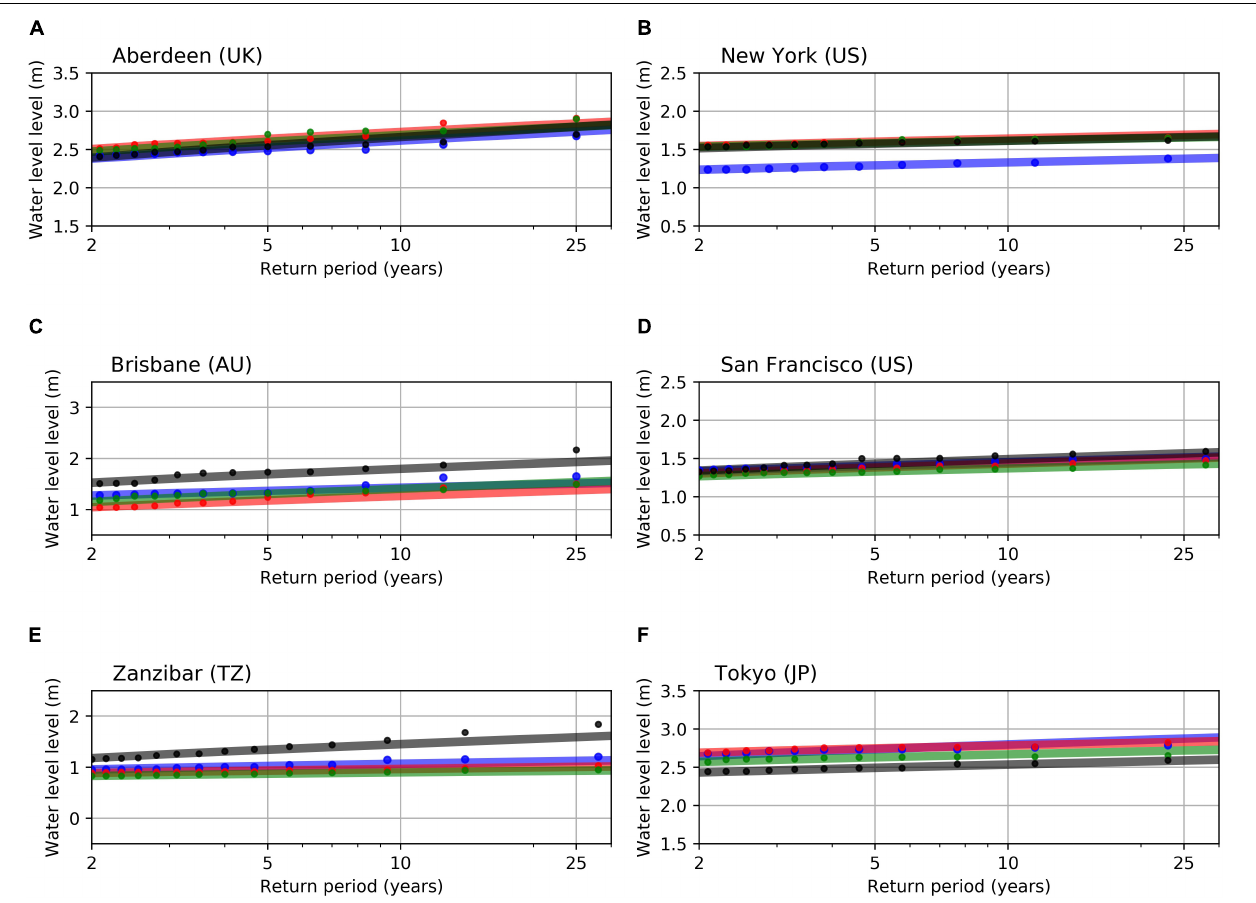
FIGURE 5 | Plots showing the Gumbel extreme value distribution fitted to the modeled and observed annual maxima at selected stations. The selected stations are (A) Aberdeen (UK), (B) New York, United States, (C) Brisbane, Australia, (D) San Fransisco, United States, (E) Zanzibar, Tanzania, and (F) Tokyo, Japan. The black line indicates the observed maxima, whereas GTSR, CoDEC-ERA5, and CoDEC-HIST are plotted as a blue, red, and green line, respectively. We also plot the empirical probabilities of the annual maxima (dots) based on the Weibull plotting positions.